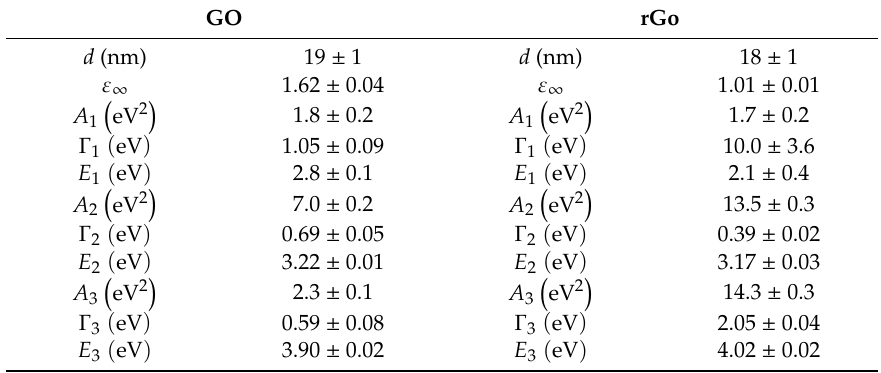
Table 1. Lorentz oscillators parameters for graphene oxide and thermally reduced graphene oxide films on SiO 2 / Si. Amplitude A k has a unit of eV 2 , center energy E k and broadening Γ k have units of eV; d is the thickness of film in nm; the high-frequency dielectric constant ε ∞ is dimensionless.